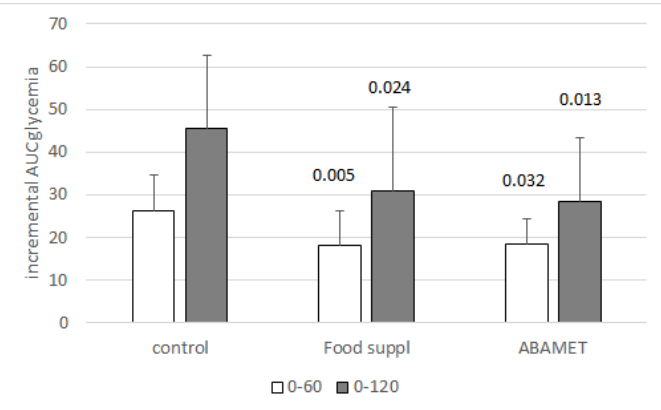
Figure 2. The active ingredient of the food supplement is the ABA-containing vegetal extract. Six volunteers introduced a standardized carbohydrate-rich breakfast, one without any supplement (control), one with one tablet of the formulated food supplement (Food suppl) and another taking only the amount of vegetal extract (ABAMET ® ) present in one tablet of the food supplement. The three experiments were performed one week apart. The food supplement or ABAMET ® were taken before the meal [20] Mean ± SD values of the incremental AUC of glycemia in the time frames 0–60 and 0–120 min are shown. p values by paired, two-tailed t -test of the comparison between each bar with the respective control bar are shown.